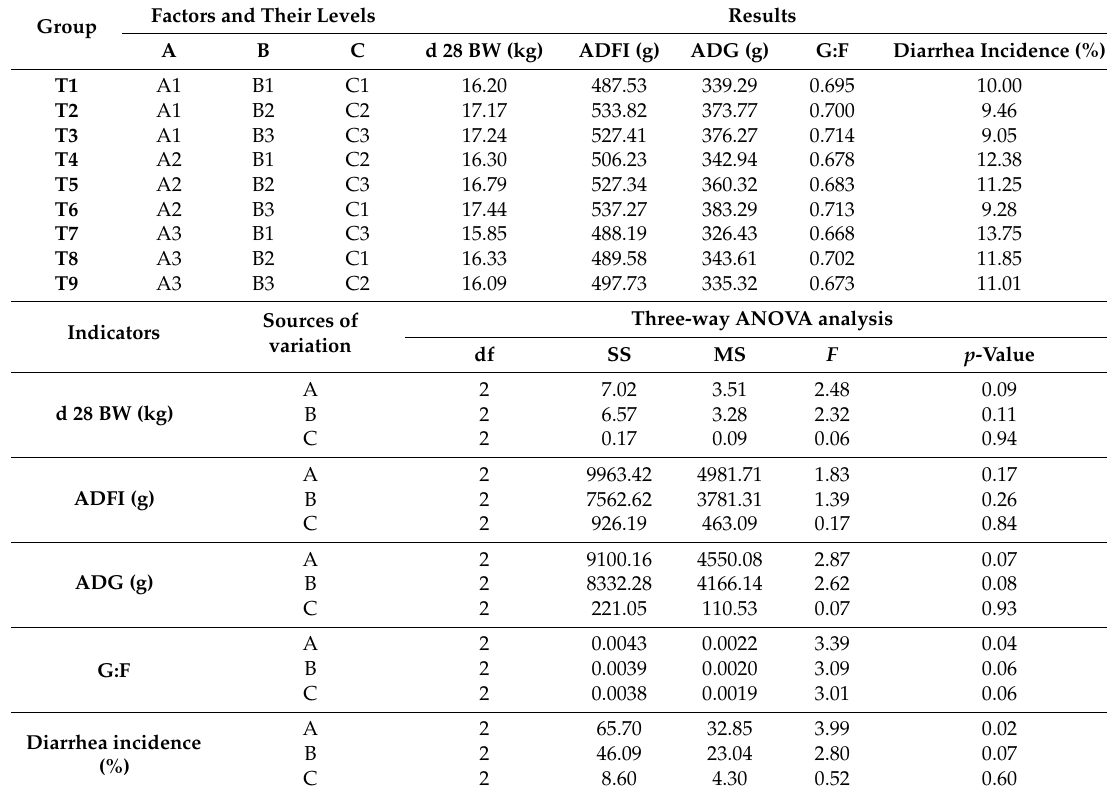
Table 6. The three-way ANOVA of the orthogonal experiment.